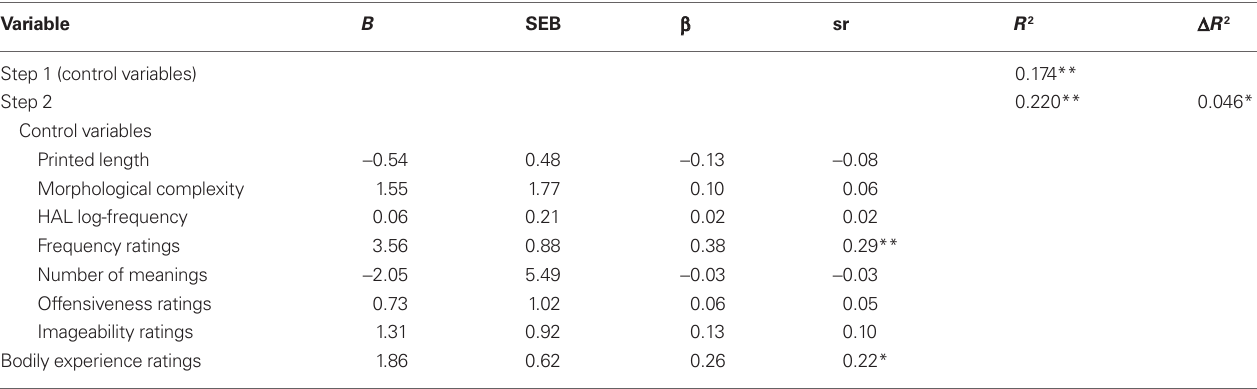
Table 6 | Results of hierarchical multiple regression analysis for insult detection task word recall data for Experiment